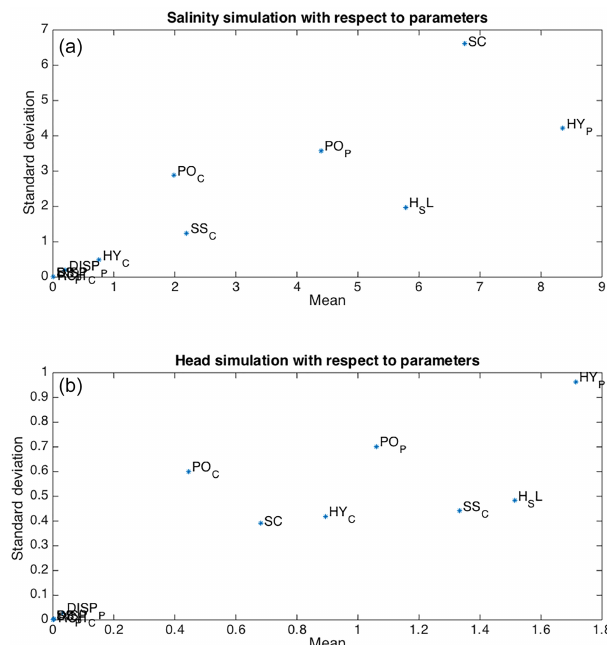
Figure 11. Mean and standard deviation of the EEs (elementary effects) of parameters with respect to simulations in the porous medium (column no. 35, layer no. 24) in the global sensitivity anal- ysis by the Morris method: (a) salinity simulation (top); (b) head simulation